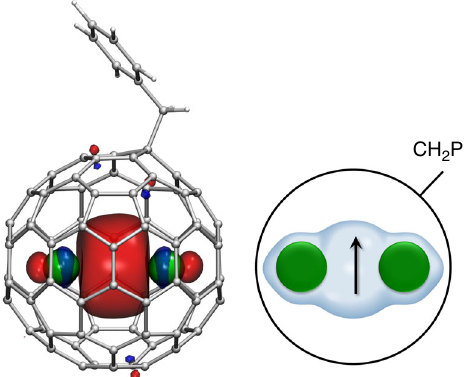
Fig. 1 Molecular structure of Ln 2 @C 80 (CH 2 Ph). Single-occupied Ln – Ln bonding molecular orbital (left; carbons are gray, hydrogens are white, lanthanides are green), and schematic depiction of the molecule (right; the arrow indicates an unpaired electron residing on the Ln – Ln bonding